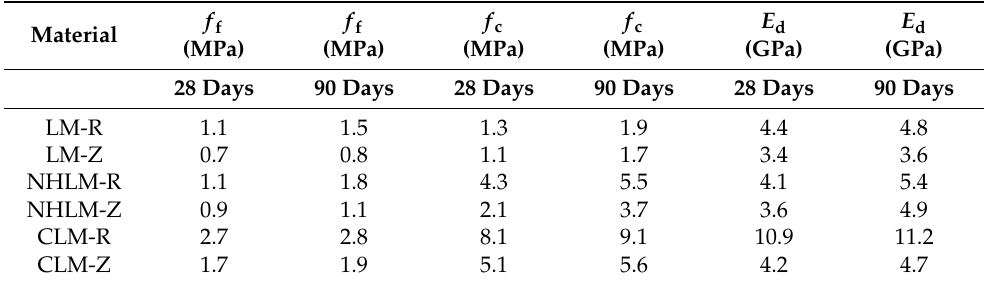
Table 5. The mechanical properties of the hardened